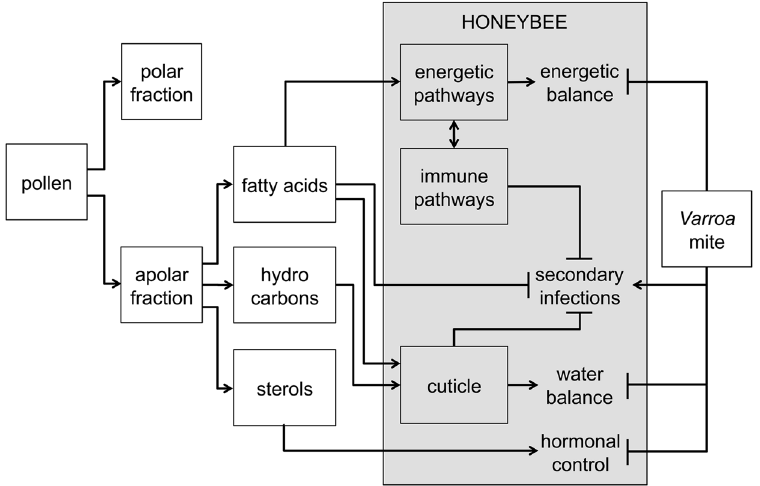
Figure 7. Diagram outlining discussed hypotheses about the mechanisms underpinning the beneficial role of pollen in mitigating the negative impacts of Varroa mite